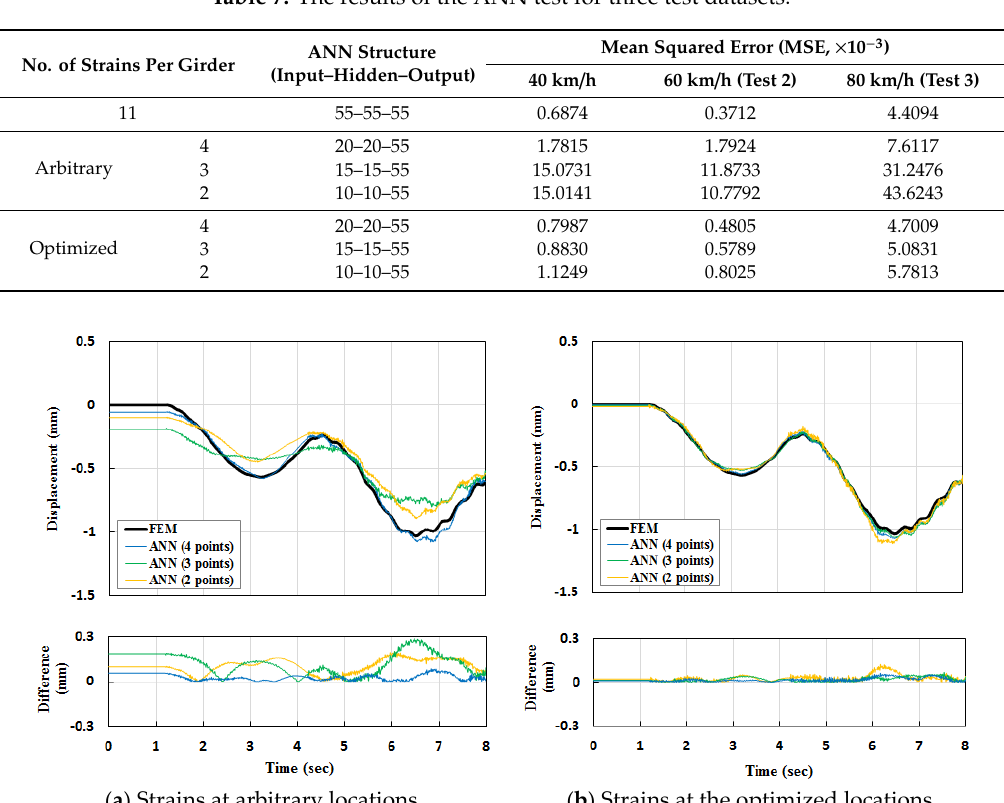
Figure 13. Displacements over time at center girder for 40 km/h test dataset.